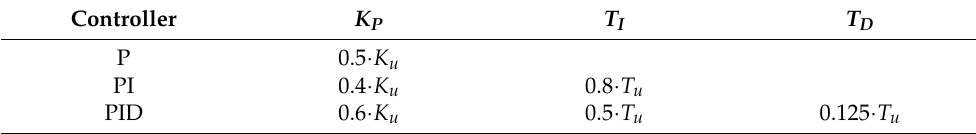
Table 1. PID control parameters tuning (Ziegler-Nichols frequency response method)